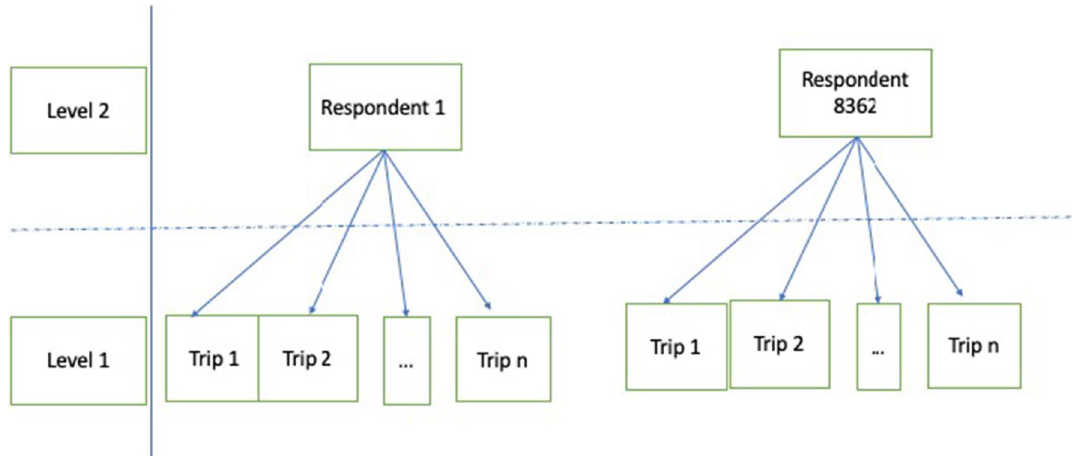
Fig. 2 Multilevel modeling with our data structure (N